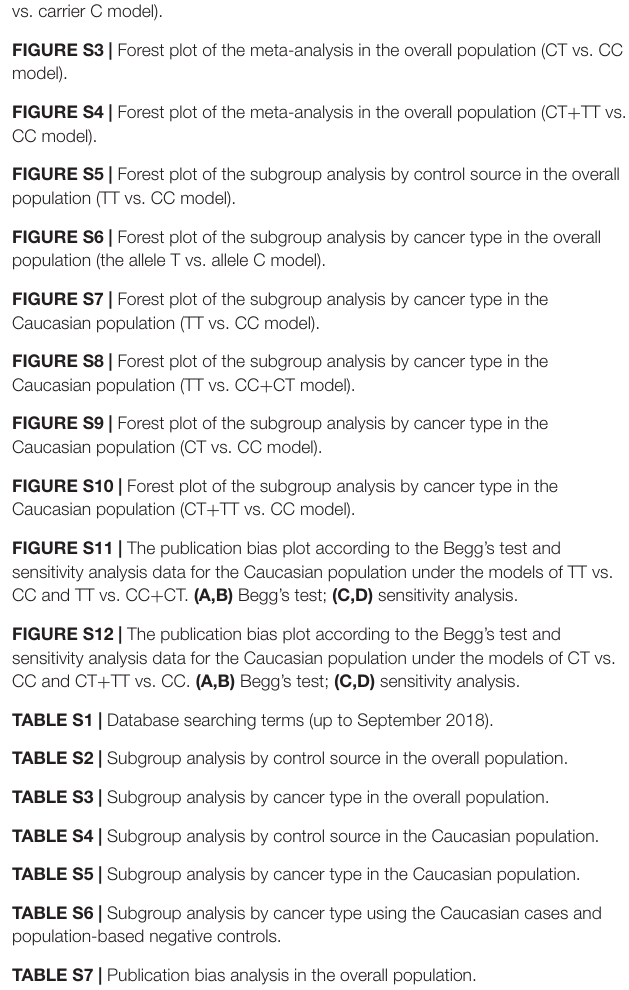
TABLE S1 | Database searching terms (up to September 2018). TABLE S2 | Subgroup analysis by control source in the overall population. TABLE S3 | Subgroup analysis by cancer type in the overall population. TABLE S4 | Subgroup analysis by control source in the Caucasian population. TABLE S5 | Subgroup analysis by cancer type in the Caucasian population. TABLE S6 | Subgroup analysis by cancer type using the Caucasian cases and population-based negative controls. TABLE S7 | Publication bias analysis in the overall population. TABLE S8 | Publication bias analysis in the Caucasian population. TABLE S9 | Publication bias analysis in the Caucasian cases and population-based negative